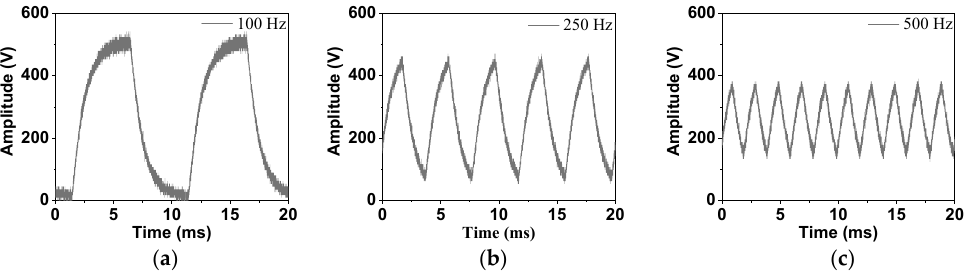
Figure 2. The voltages applied to the sample based on the traditional circuit design: ( a ) 100 Hz, ( b ) 250 Hz, ( c ) 500 Hz.